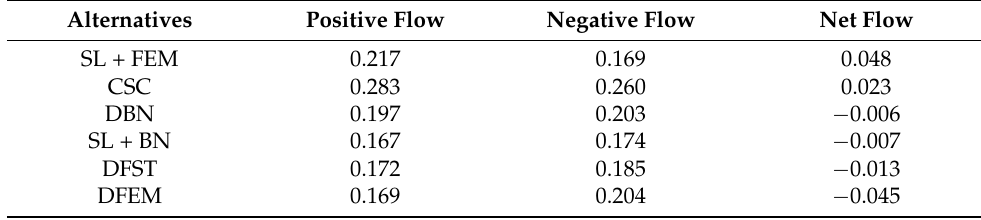
Table 5. Importance of flows and ranking obtained in the PROMETHEE-SAPEVO-M1 method.